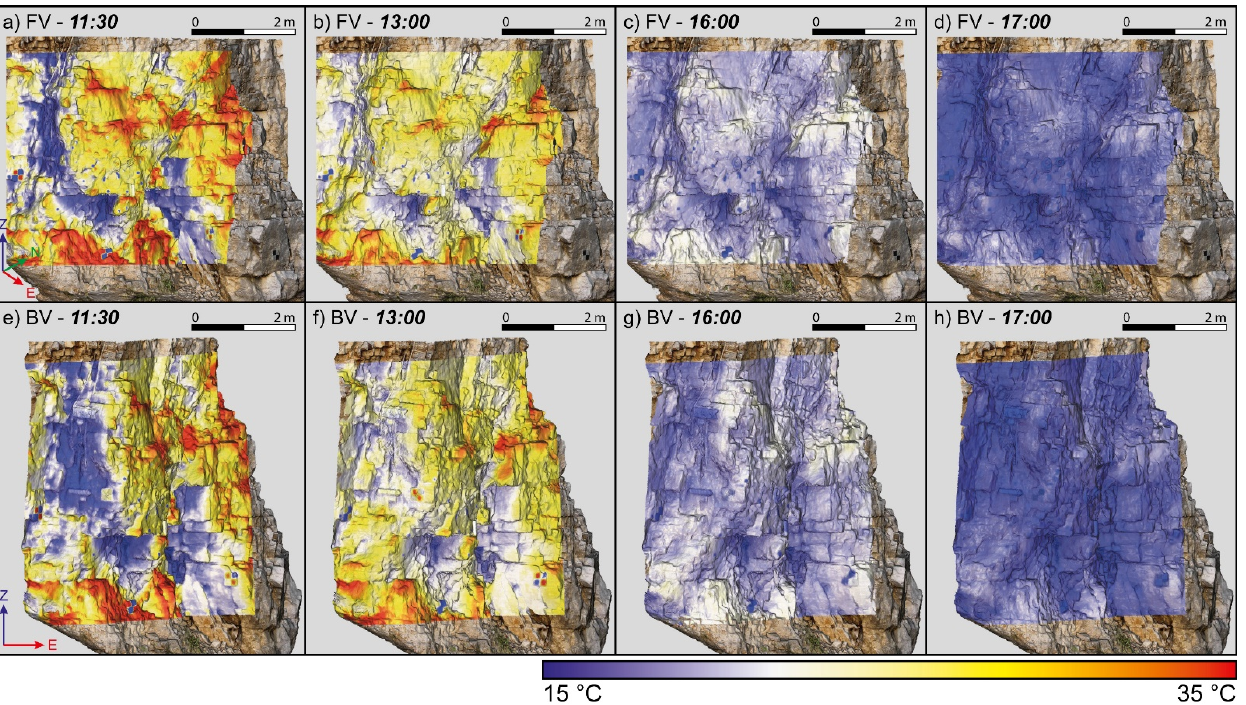
Figure 5. 3D TIR merged point clouds of the spring survey at four different acquisition times; ( a – d ) Front view (FV), i.e., Eastward, and ( e – h ) back view (BV), i.e., Southward, of the investigated rock block are shown for each point cloud in order to demonstrate the great enhancement in the visualization of surface temperature distributions and evolution in time.